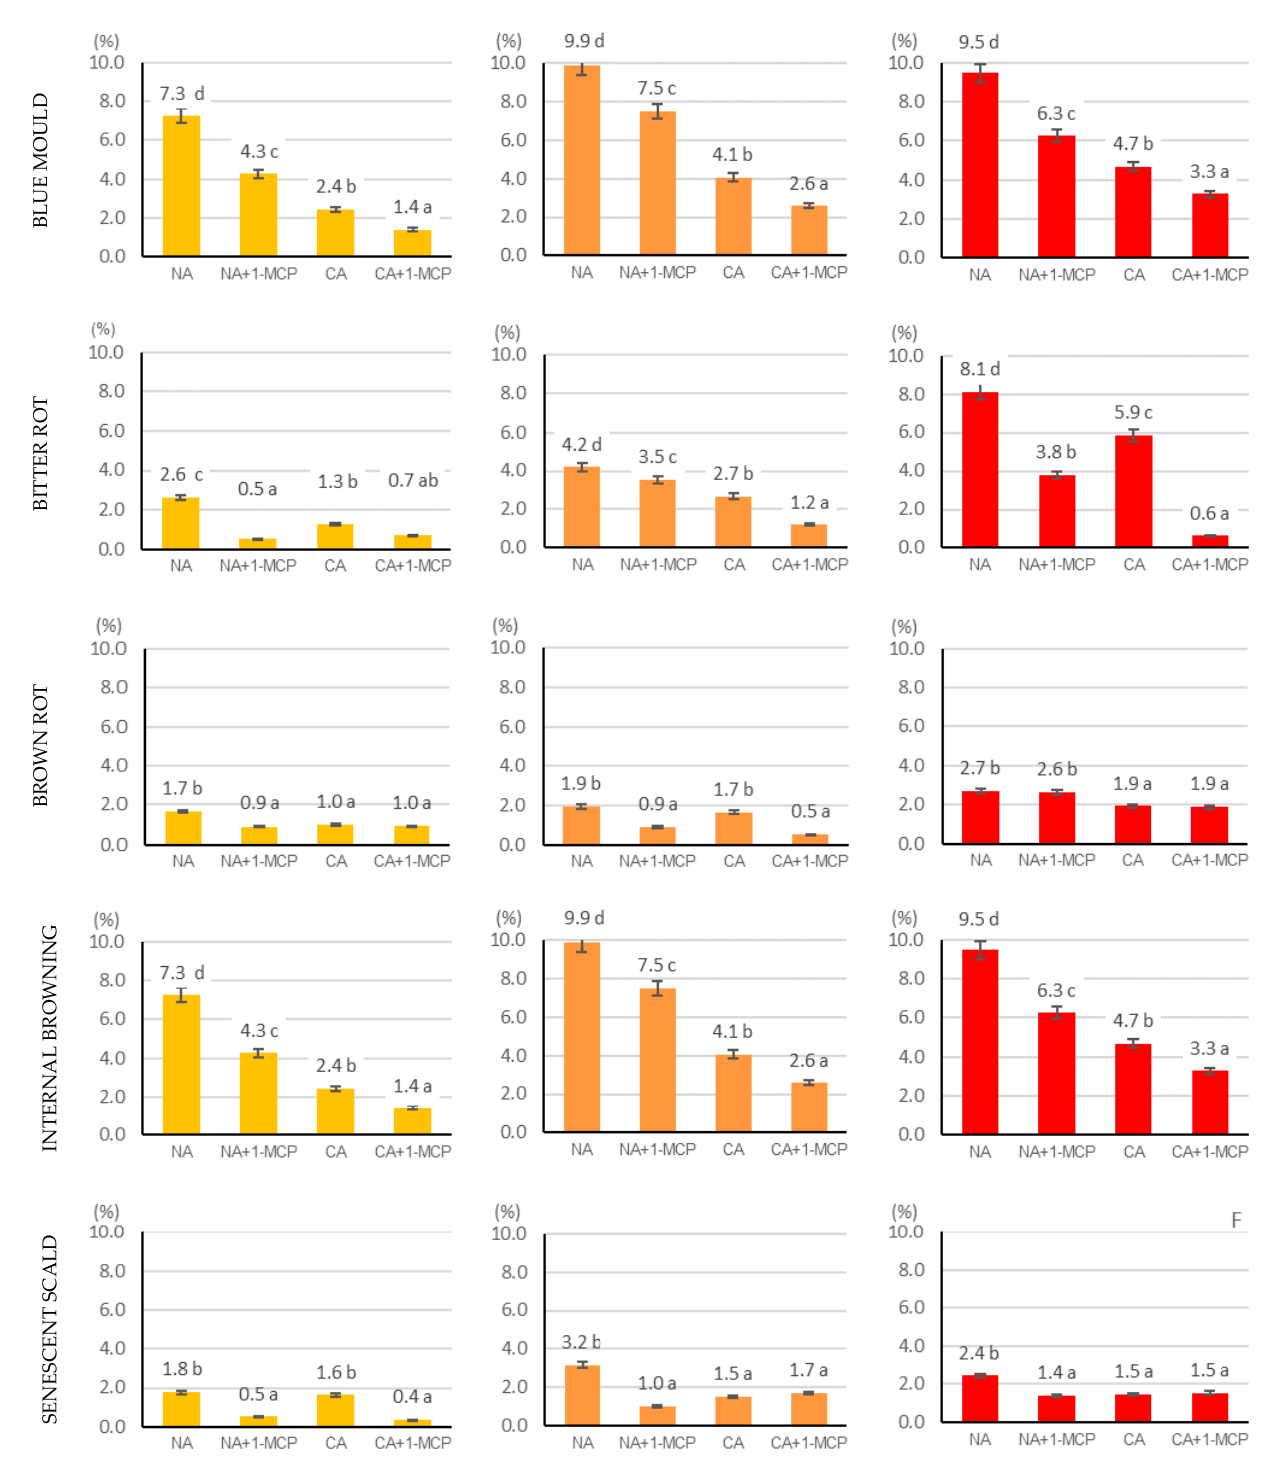
Figure 3. Impact of storage technology on the incidence of postharvest diseases and disorders in 2011–2013. Numbers with different letters were significantly different at p = 0.05 according to Duncan’s test. The data are expressed as mean ± SD (n = 10). NA—normal atmosphere; NA + 1-MCP—normal atmosphere + 1-methylcyclopropene; CA—controlled atmosphere; CA + 1-MCP—controlled atmosphere + 1-methylcyclopropene.